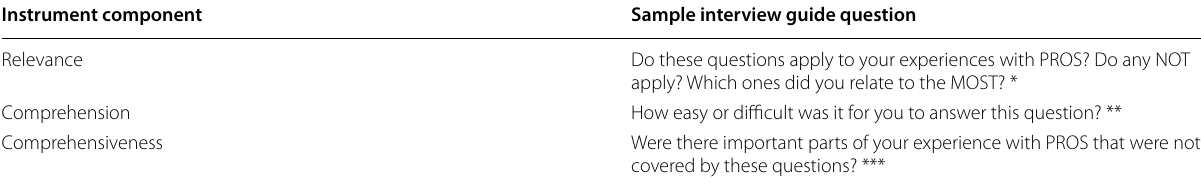
Table 1 Sample interview guide questions Instrument